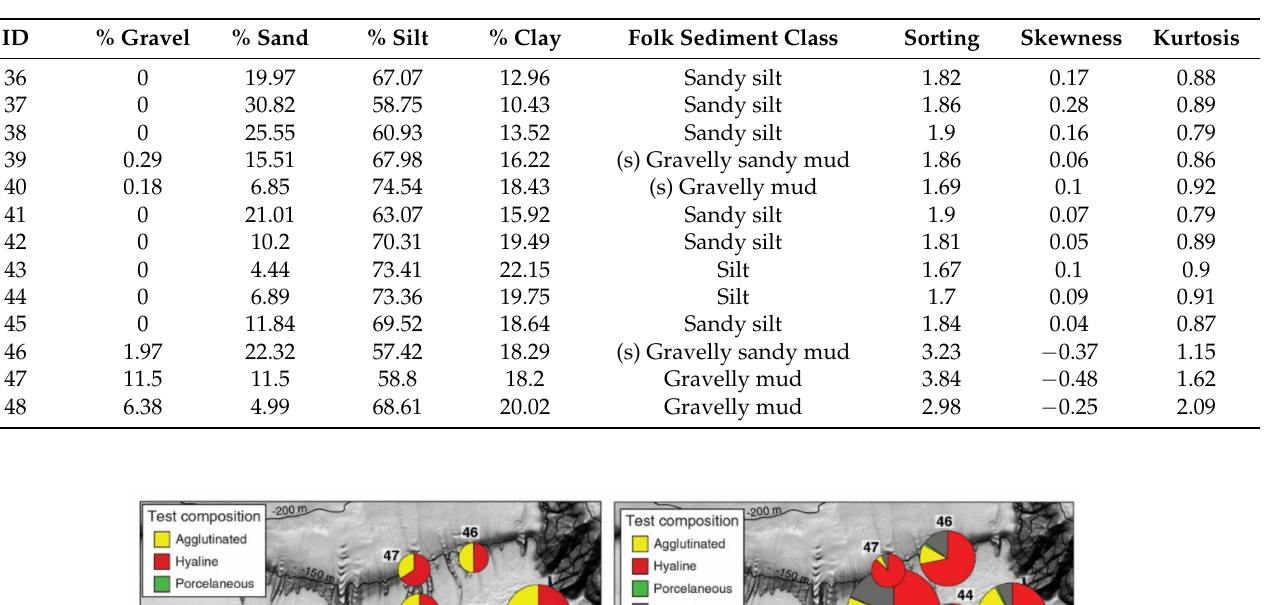
Table 2. Granulometric characteristics of sediment samples collected during Epica cruise. (s) slightly.